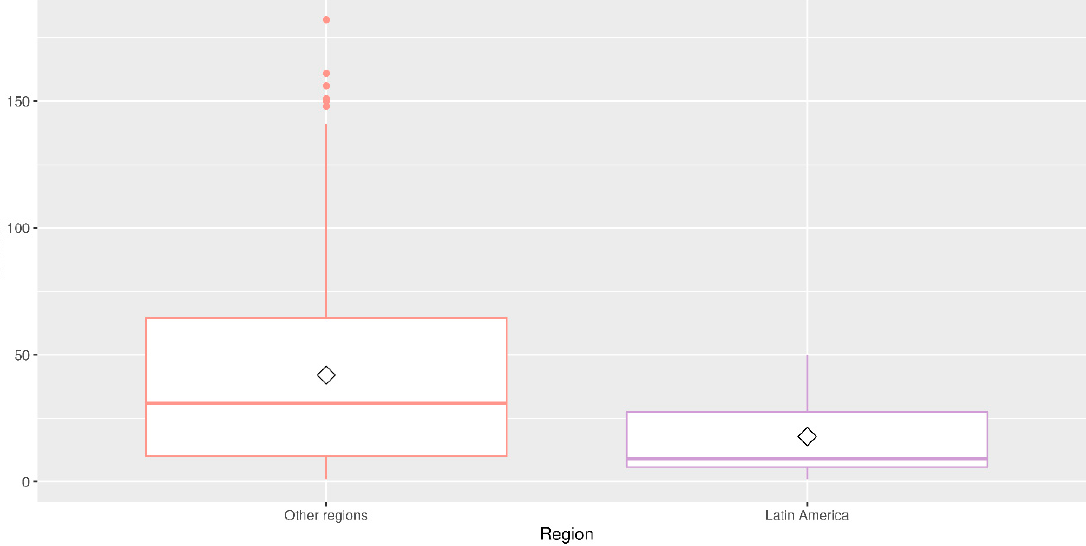
Figure 2. Comparison of H-Index between LAC and other regions.